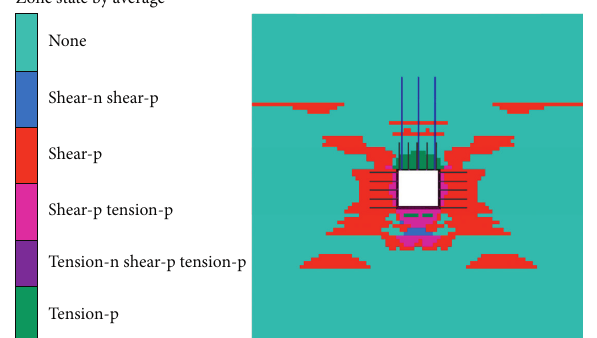
Figure 23: Plastic zone of #15 haulage roadway.